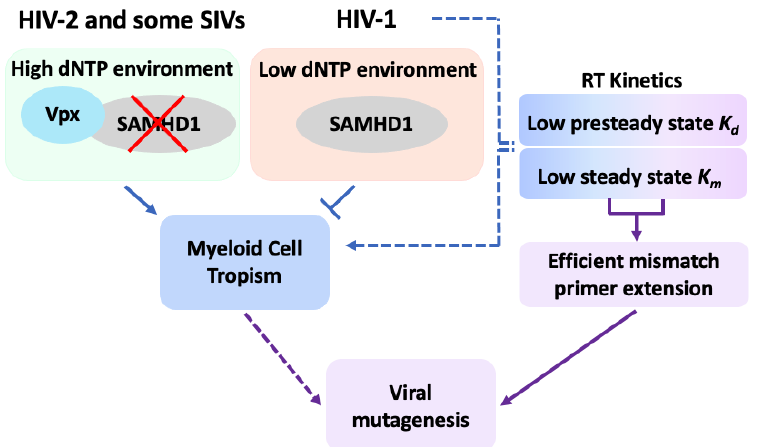
Figure 3. Model of mechanistic interplay among cellular dNTP levels, SAMHD1, RT enzyme kinetics, cell tropism, and genomic mutagenesis of HIV-1. In non-dividing cells, such as macrophages, dNTP pool is typically low as a result of the dNTPase activity of SAMHD1. Lentiviruses harboring Vpx, such as HIV-2, and several SIV strains counteract this antiviral restriction effect of SAMHD1 by proteasomally degrading SAMHD1 and elevating cellular dNTP levels, which promotes viral reverse-transcription kinetics in macrophages. By contrast, HIV-1 bypasses the low-dNTP pool of macrophages (dashed blue lines) via the unique kinetic properties of RT (low K d and K m values), which facilitate viral reverse transcription within this limited-dNTP cellular environment. This mechanistically contributes towards the myeloid-cell tropism of HIV-1. Concomitantly, this uniquely efficient dNTP incorporation efficiency of HIV-1 RT can also promote the high efficiency of HIV-1 RT in mismatched-primer extension, which can increase viral mutagenesis, suggesting that myeloid cell tropism and high genomic variability of HIV-1 are mechanistically connected (dashed purple lines).